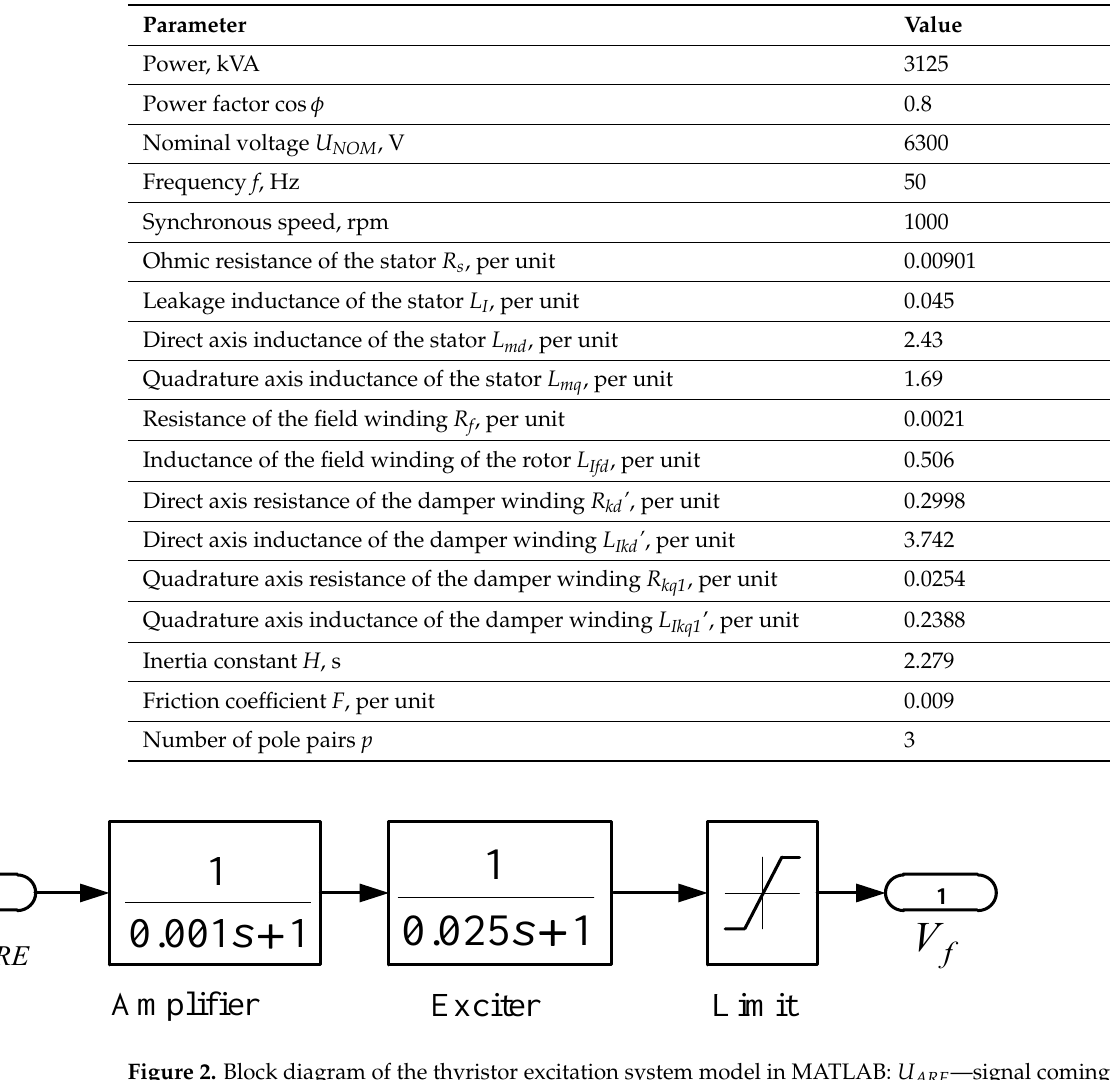
Table 1. Parameters of the synchronous machine SGS-14-1-100-6U.